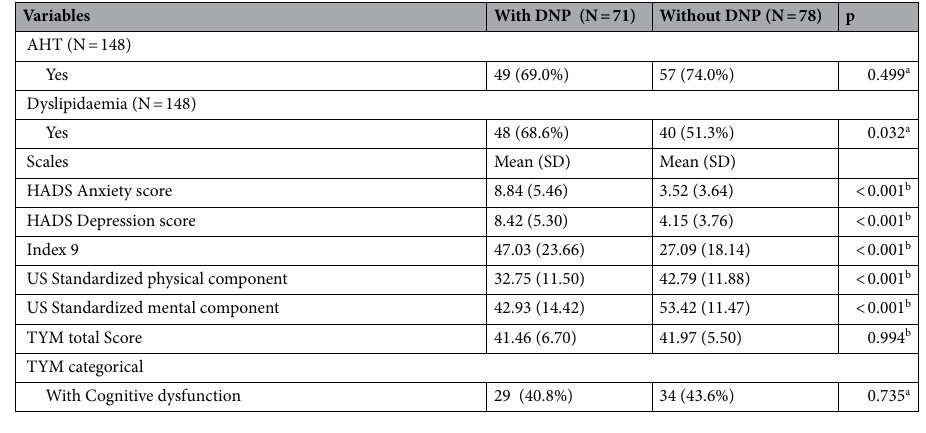
Table 1. Characteristics of the patients with and without DNP. a Pearson’s chi-squared. b Mann–Whitney. c Likelihood ratio. d Student T. SD = Standard Deviation; BMI = Body Mass Index; AHT = Arterial